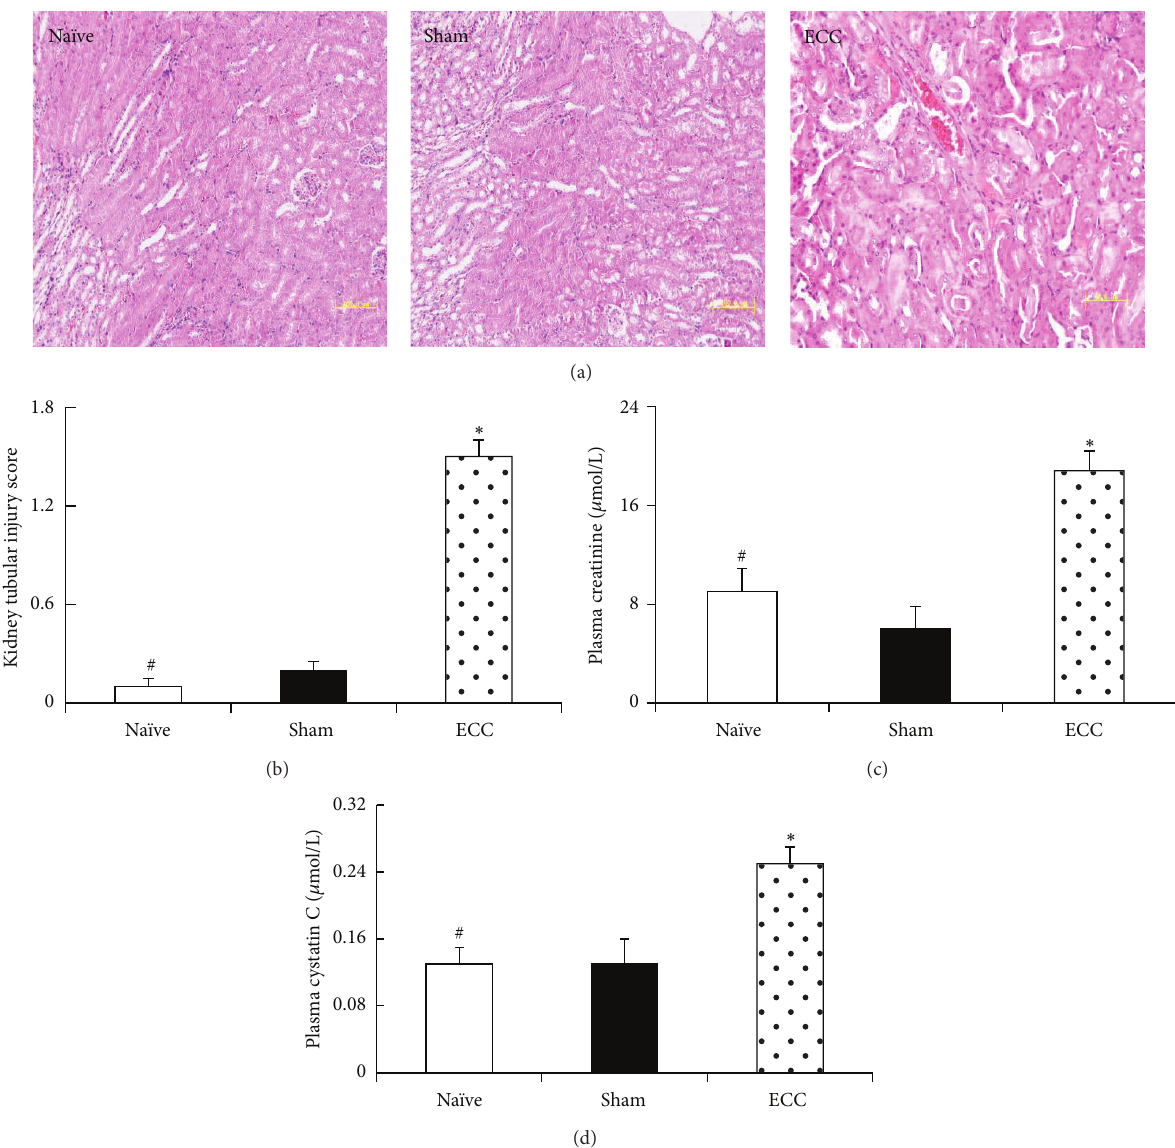
Figure 5: Kidney function and tissue morphology after ECC. Mice were treated as described in Figure 2, and kidney histopathology and blood analysis were performed at the end of the experiment. (a) Kidney sections were stained with hematoxylin and eosin and examined by a pathologist blinded to treatment groups. (b) Extent of renal tubular injury was scored as described in Section 2 (magnification, 40x). Blood was collected from the right carotid artery to allow serum assays of (c) creatinine and (d) cystatin C. ∗ 𝑃 < 0.05 versus Sham, # 𝑃 < 0.05 versus